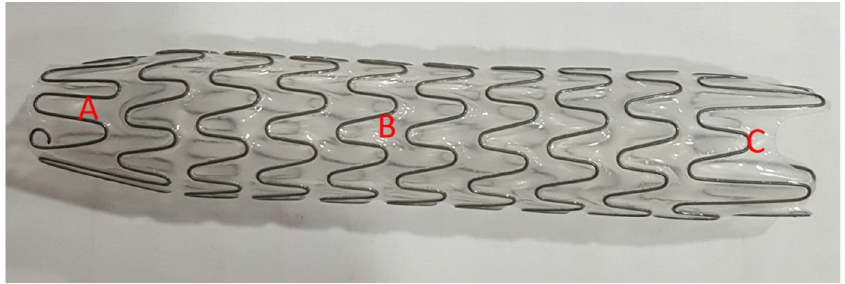
Figure 2. An Allium bulbar urethral stent (BUS). ( A ) Soft sphincteric segment; ( B ) high radial force body; ( C ) soft distal segment.